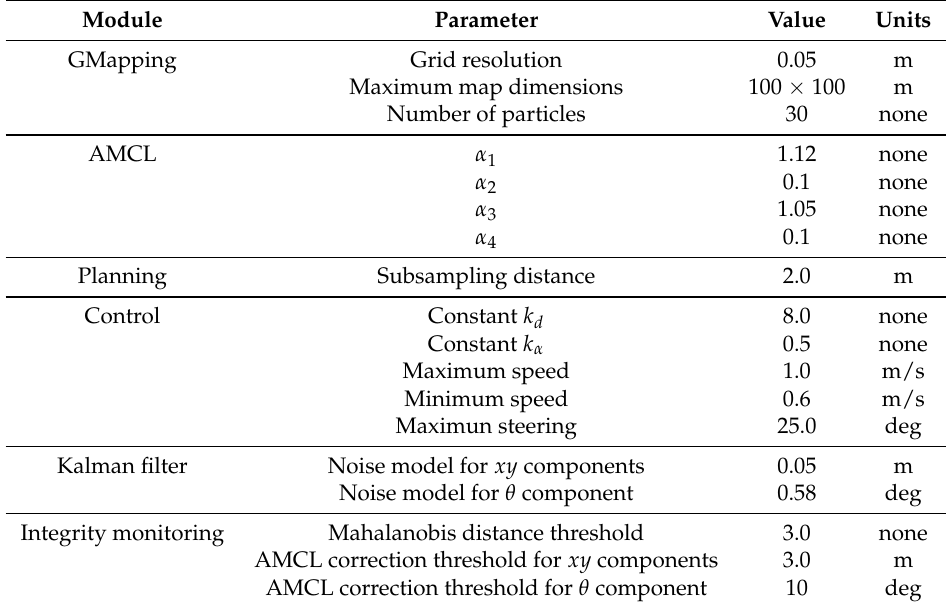
Table 1. Adjustable parameters grouped in subsystems. The table shows the values used in the experimental sessions. Some parameters depend on the robot, as is the case with the parameters α of AMCL, while others depend on the environment, as the map resolution in